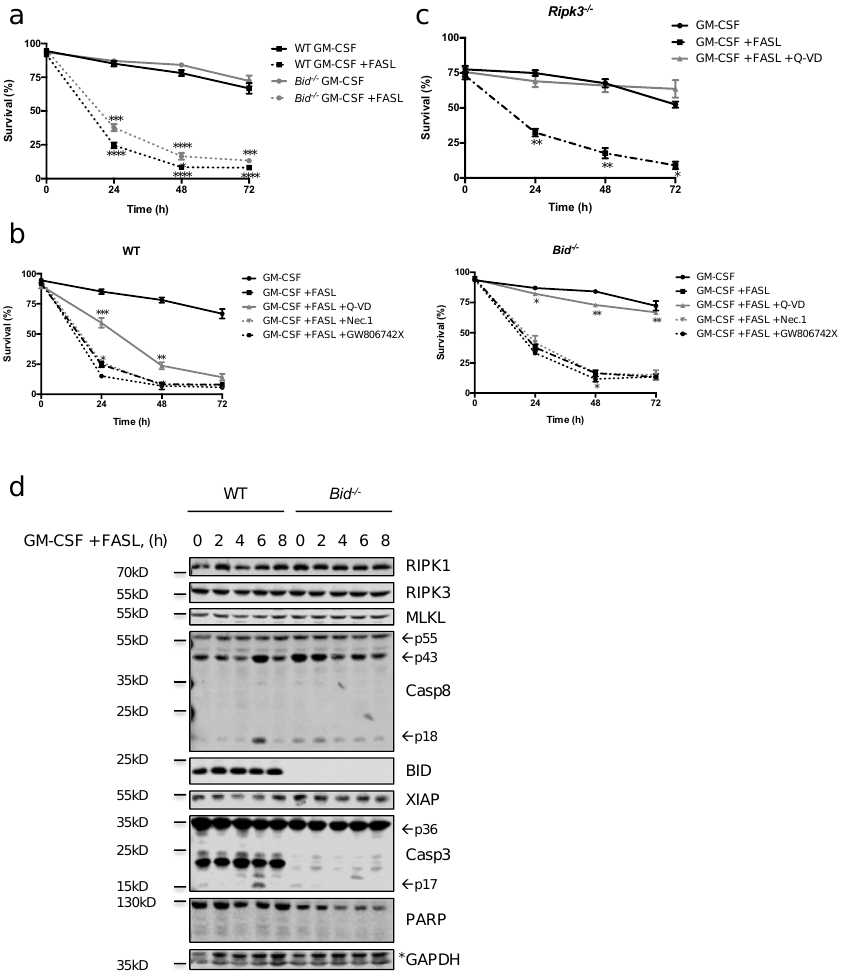
Figure 3. GM-CSF-primed neutrophils remain sensitive to FASL killing. ( a ) Primary WT and Bid −/− neutrophils were primed with GM-CSF (1 ng/mL) for 30 min prior to stimulation with FASL (100 ng/mL) for indicated time points. Viability was assessed by flow cytometry. n ≥ 3, mean ± SEM. ( b ) Primary WT and Bid − / − neutrophils were primed with GM-CSF (1 ng/mL) for 30 min and pre-treated with either Q-VD-OPh (20 µ M), Nec.1 (20 µ M) or the mouse MLKL inhibitor GW806742X (1 μ M) for 30 min followed by stimulation with FASL (100 ng/mL) for indicated time points. Viability was assessed by flow cytometry. n ≥ 3, mean ± SEM. ( c ) In vitro differentiated Ripk3 −/− neutrophils were primed with GM-CSF (1 ng/mL) for 30 min prior to stimulation with FASL (100 ng/mL) with or without Q-VD-OPh (20 µ M) for indicated time points. Viability was assessed by flow cytometry. n ≥ 3, mean ± SEM. ( a – c ): p < 0.05 (*), p < 0.01 (**), p < 0.005 (***) and p < 0.001 (****). ( d ) In vitro differentiated WT and Bid − / − neutrophils were primed with GM-CSF (1 ng/mL) for 30 min and subsequently treated with FASL (100 ng/mL) for 0–8 h. Lysates were assessed by immunoblotting. Presented immunoblots are representative of at least two independent